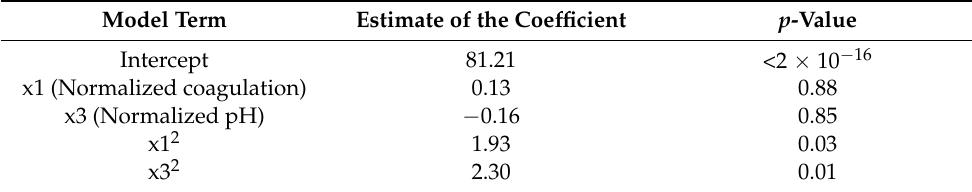
Table 2. The final selected model for COD removal. Model Term Estimate of the Coefficient p